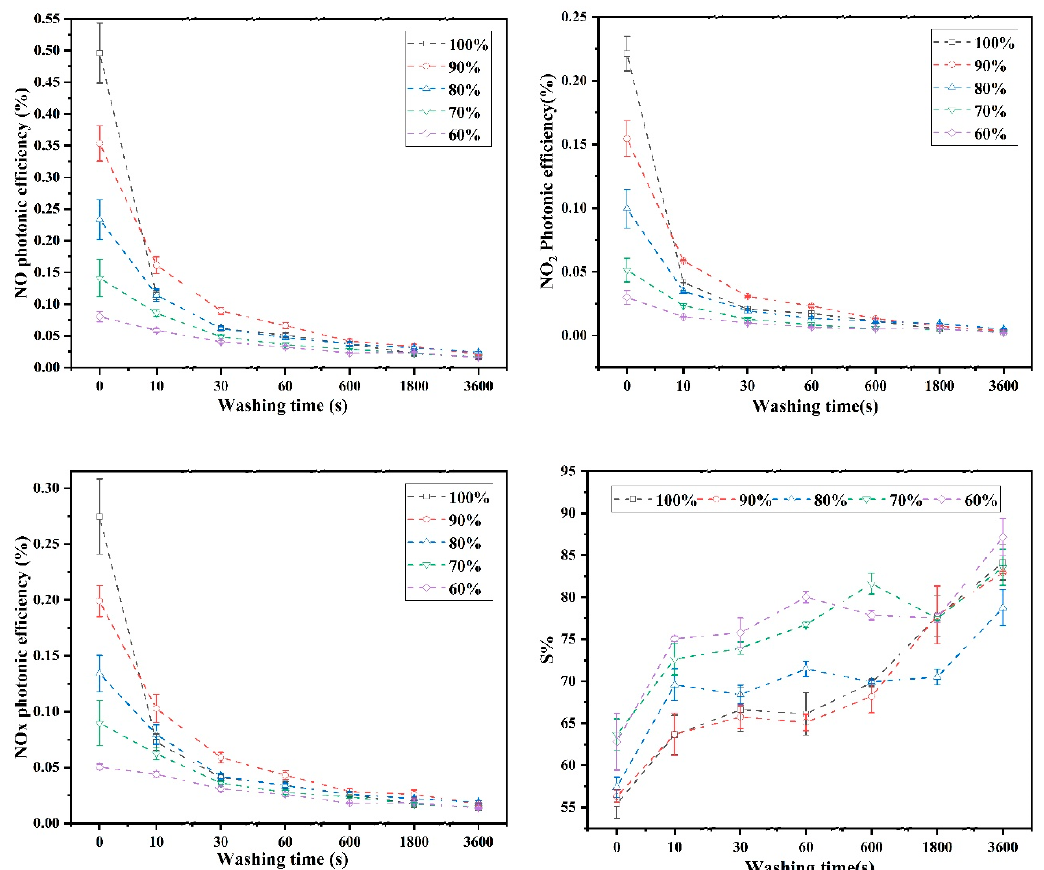
Figure7. De-NOxphotonice ffi cienciesandnitrateselectivity(S%)ofquartzsand-supportedTiO 2 -C 2 S( γ ) Figure 7. De-NOx photonic efficiencies and nitrate selectivity (S%) of quartz sand-supported TiO 2 - Catalysts 2020 , 10 , x FOR PEER REVIEW compositions before and after the washing test. C 2 S( γ ) compositions before and after the washing test.